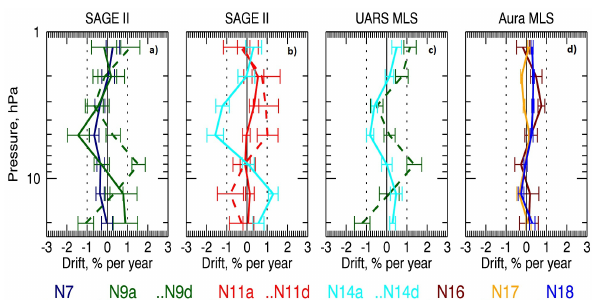
Fig. 13. Vertical profiles of the drifts for individual SBUV instru- ments relative to independent satellite measurements for the wide latitudinal band 50 ◦ S–50 ◦ N. The horizontal error bars indicate two times the standard deviation of the slope. Colors correspond to in- dividual SBUV instruments, and dashed lines correspond to the descending modes. (a) Drifts for N7 and ascending and descend- ing modes of N9 relative to SAGE II; (b) drifts for ascending and descending modes of N11 and ascending mode of N14 relative to SAGE II; (c) drifts for descending mode of N9 and ascending mode of NOAA14 relative to UARS MLS; (d) drifts for N16, N17 and N18 relative to Aura